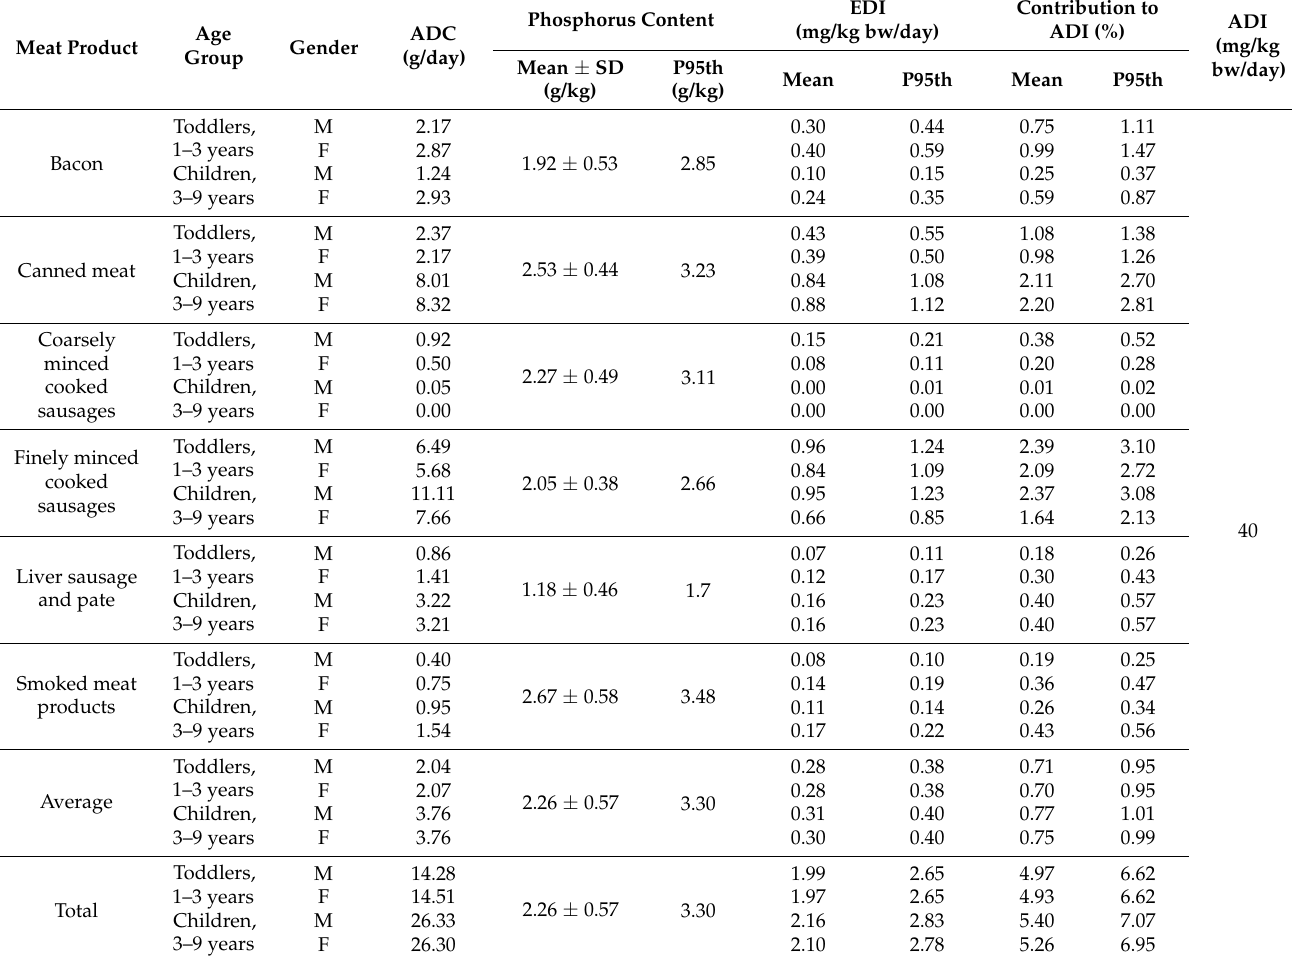
Table 7. EDI of phosphorus and risk characterization of phosphorus intake (mg/kg